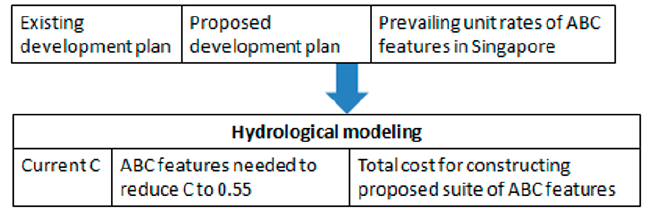
Figure 3. Methodology for assessing the effectiveness of Active, Beautiful, Clean (ABC) features.